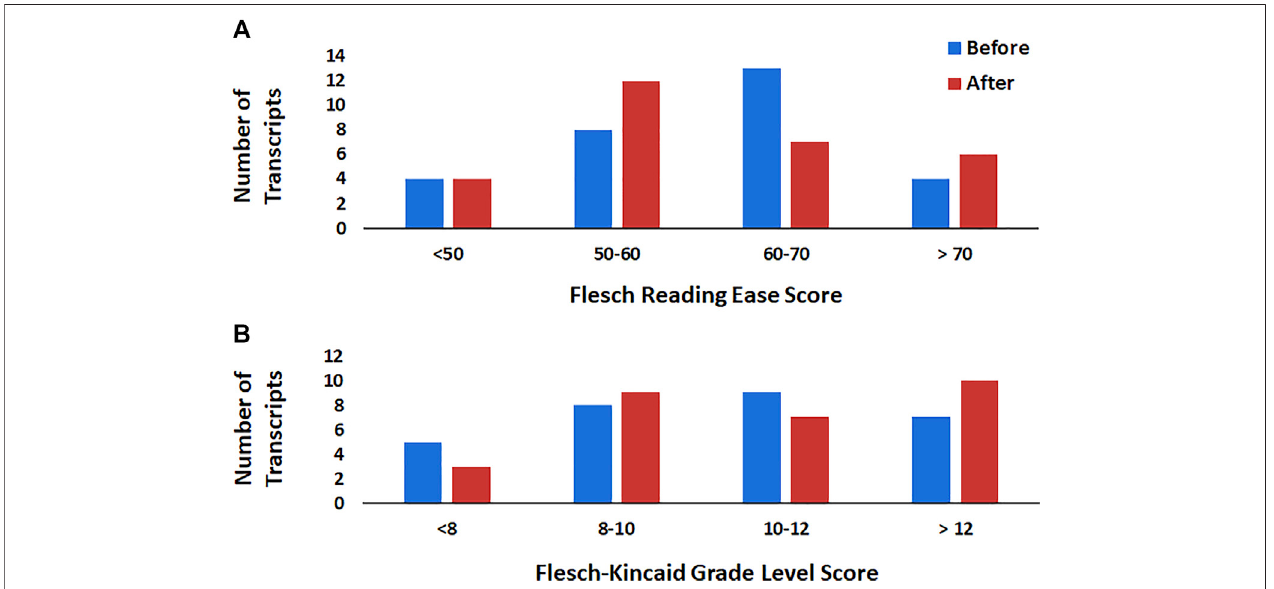
FIGURE1 | Scores re fl ecting the (A) reading ease and (B) grade level assignment ofthe transcriptsof trainees before (blue) and after (red) science communication training. There wasno signi fi cant change inthe mean reading ease or grade level scores after training, suggestingthat, overall, trainees did not simplify the way thatthey spoke to audiences after training.